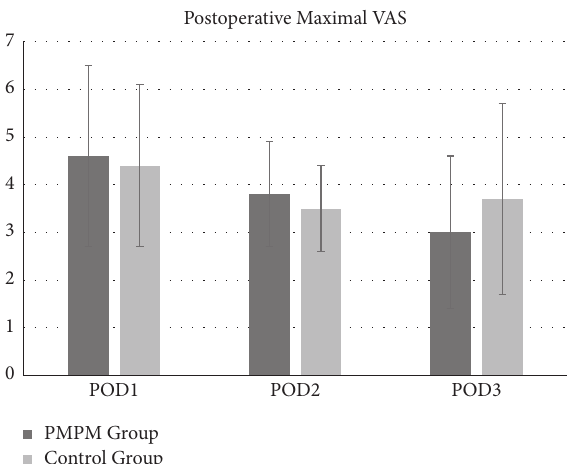
Figure 1: The maximal VAS score on POD1, POD2, and POD3 of patients in the PMPM group and control group.